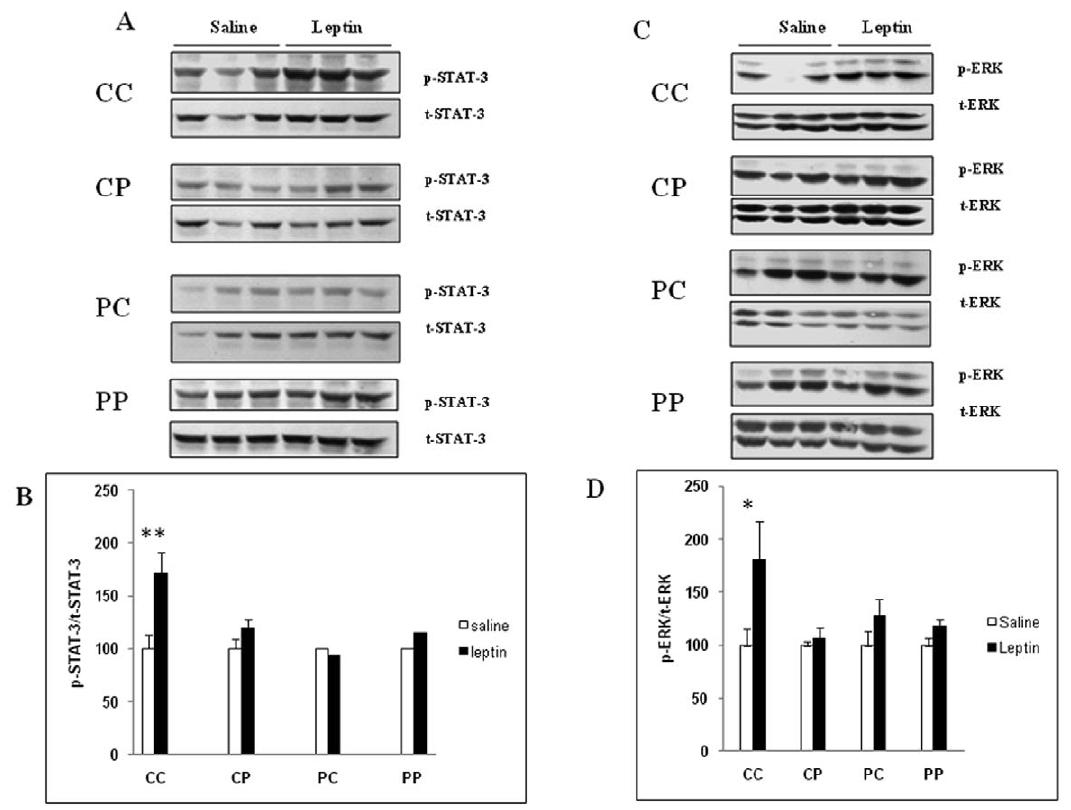
Figure 4. Phosphorylation of STAT-3 and ERK in the hypothalamus of male offspring born to dams fed the control diet (C) or highly palatable diet (P). At weaning four groups of male pups (CC, CP, PC, PP) were formed and named according to the post weaning diet (C or P, first letter) and to maternal diet (C or P, second letter). Each goup contained 20 rats was divided into two sub-groups that received by IP either saline (n=10) or leptin (n=10). In each group, the sensitivity toward leptin was assessed by a significant elevation of the mean p-STAT-3/t-STAT-3 and p- ERK/t-ERK ratio in leptin-injected compared to saline-injected rats. Panel A and C show representative western-blots for total and phosphorylated STAT-3 and ERK, respectrively. Panels B and D show the mean ratio band density of phosphorylated and total STAT-3 and ERK, respectively; (**p , 0.005; * p , 0.05).